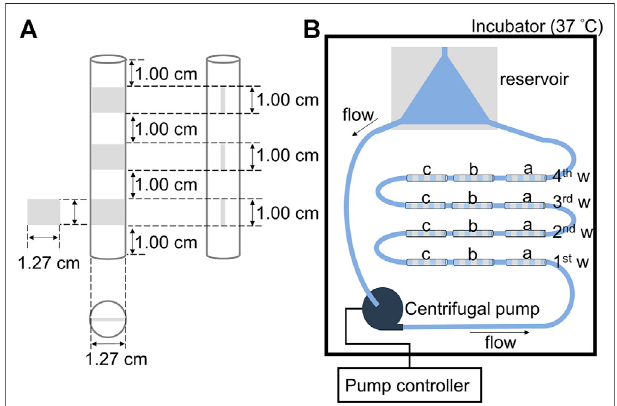
FIGURE 2 | Schematic circulating system for evaluating the stability of the polymer fi lm: (A) The tubing with three pieces of silicone elastomer (SE) sheets of 1.27 × 1.00 cm located inside at a distance of 1.00 cm. Cross- sectional view of the tubing. (B) Illustration of the liquid fl ow circulation circuit for evaluating the stability of the cross-MPC copolymer fi lm on different pretreated SE sheets, a) oxygen plasma treated-silicone elastomer